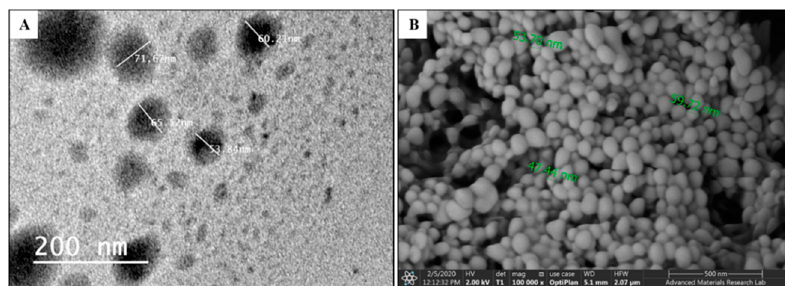
Figure 6. Morphology, surface structure and size of the optimal PTX-PLGA-NPs formulation observed using ( A ) TEM micrograph; ( B ) SEM micrograph.